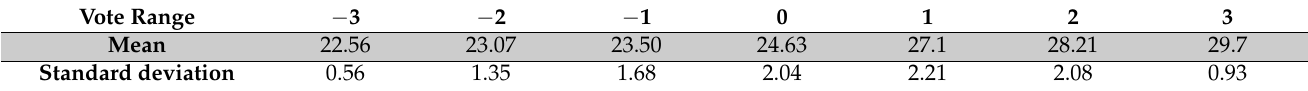
Figure 7. ( a ) Outdoor air temperature and thermal comfort votes scatter plot; ( b ) Clothing level and outdoor air temperature. Table 1. Means and standard deviations of temperatures for each thermal comfort vote